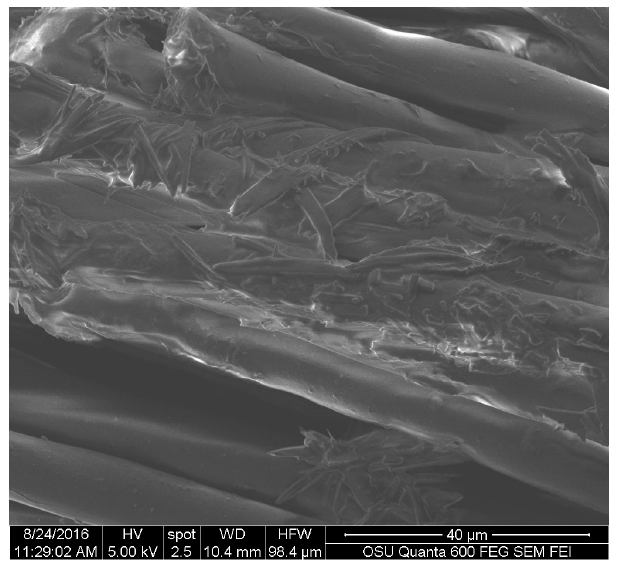
Figure 9. Pigment of S. cuboideum wrapping around polyester fibers. Picture taken with an FEI QUANTA 600 F.